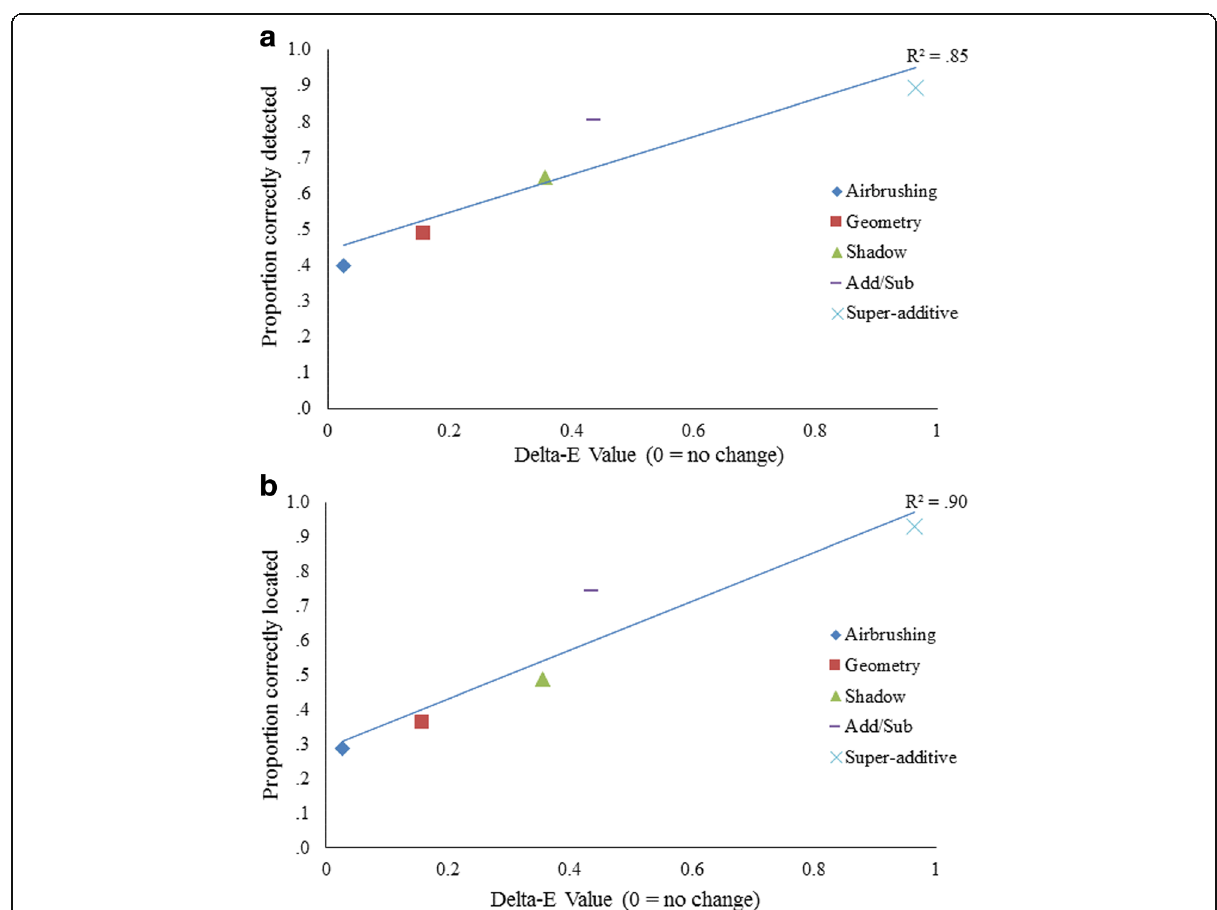
Fig. 9 Mean proportion of correctly detected ( a ) and located ( b ) image manipulations by extent of pixel distortion as measured by Delta-E. The graphs show the mean values for each of the five categories of manipulation